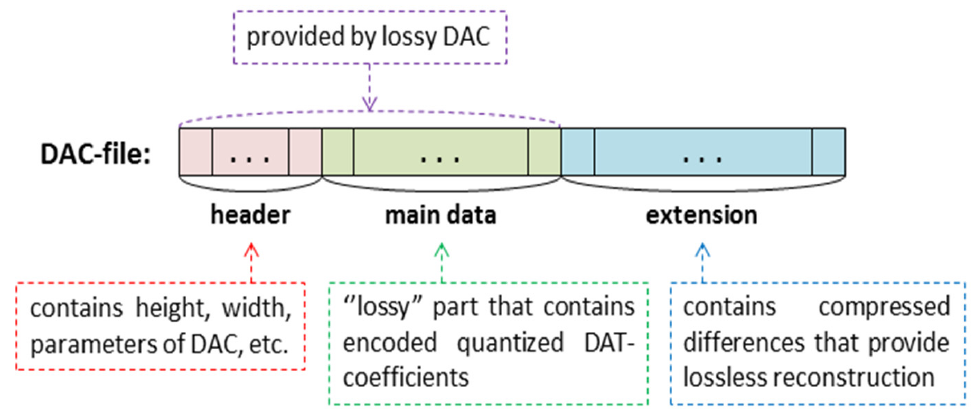
Figure 2. Extension of DAC file.